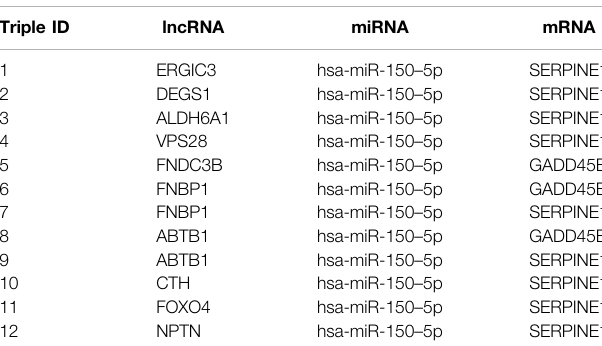
TABLE 1 | 12 core ceRNA regulatory pahyways associated with resistance to EGFR-TKIs in